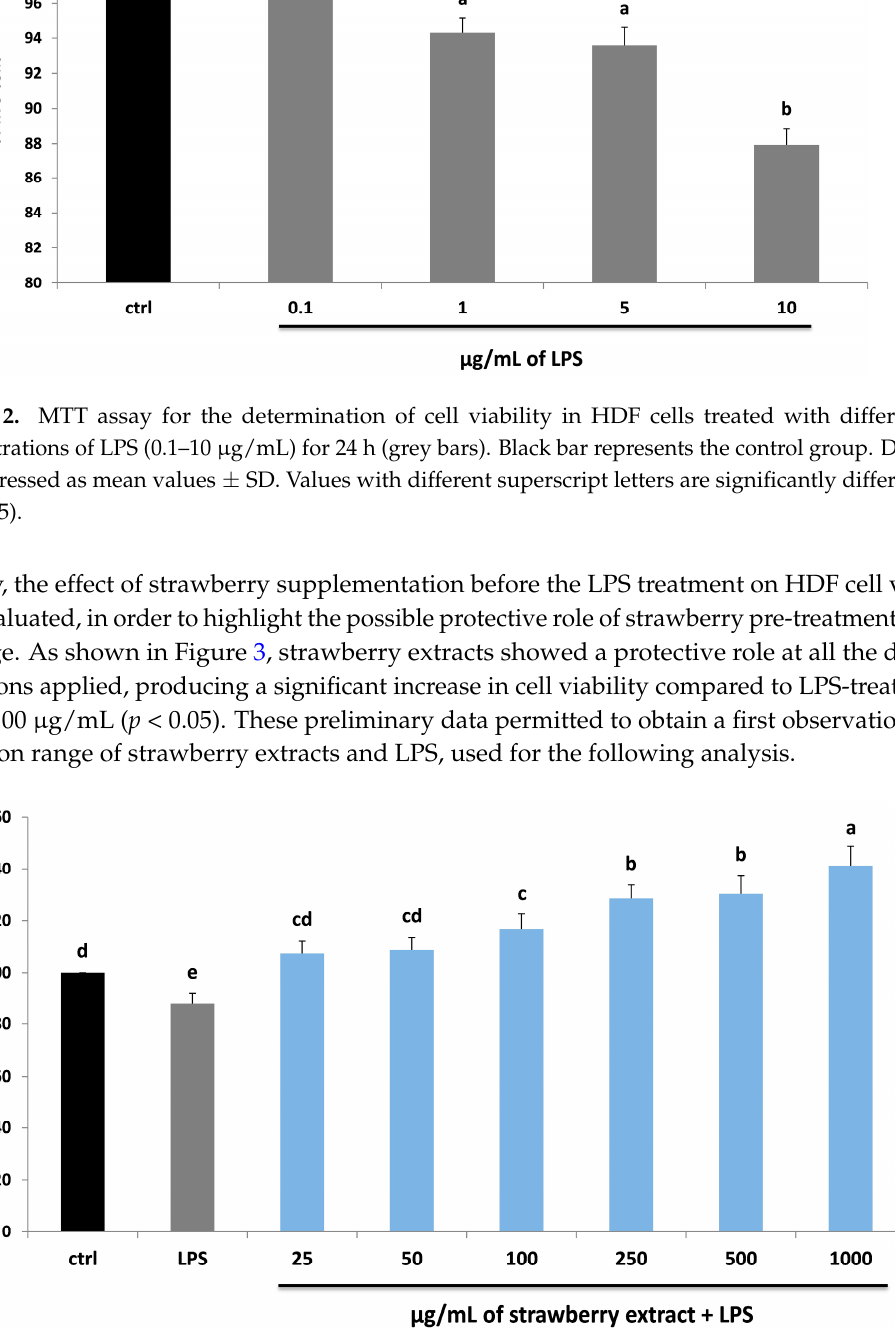
Figure 3. MTT assay for the determination of cell viability in HDF cells treated with LPS (10 µg/mL) for 24 h (grey bar) and different concentrations of strawberry extract (25–1000 µg/mL) for 24 h and then with LPS (blue bars). Black bar represents the control group. Data are expressed as mean values ± SD. Values with different superscript letters are significantly different ( p < 0.05).